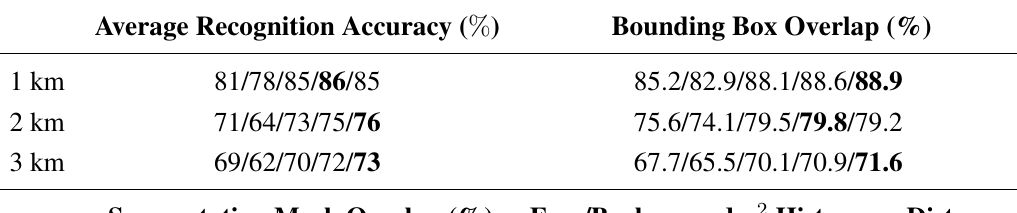
Table 2. Overall recognition and segmentation results of five methods (I/II/III/IV/V).